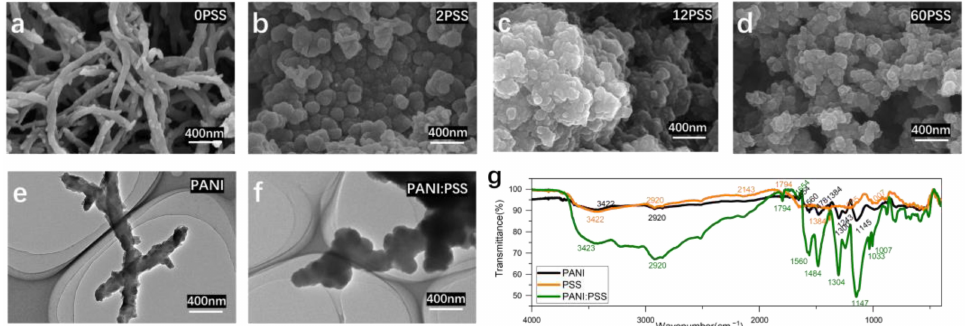
Figure 2. ( a – d ) the SEM images of PANI: PSS electroplating doped with different concentrations of PSS (Unit: mg/mL); ( e , f ) the TEM images of PANI without PSS doping and PANI: PSS (PSS:12 mg/mL); ( g ) infrared absorption spectrum of PANI, PSS, and PANI: